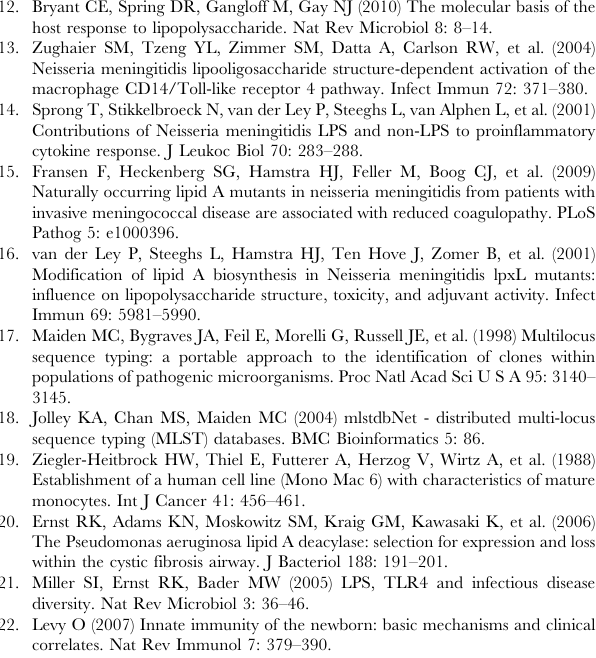
Figure S1 Type and position of mutations in the lpxL1 - gene of strain MC58. Table S1 Strain and patient characteristics of menin- gococcal lipid A variant disease